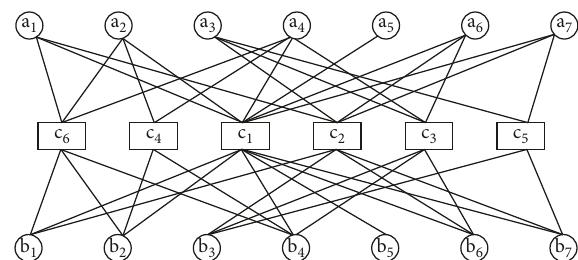
Figure 2: Hyper graph (strength of manufacturers in view of shop keepers, customers, pharmacies).